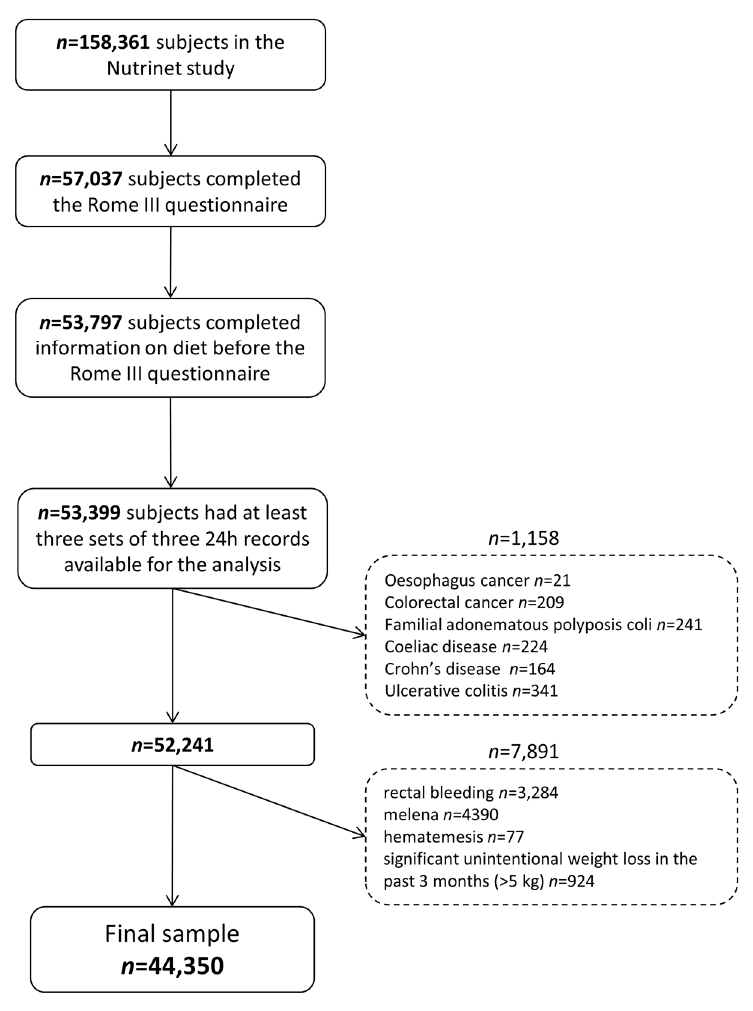
Figure 1. Flowchart of the study.